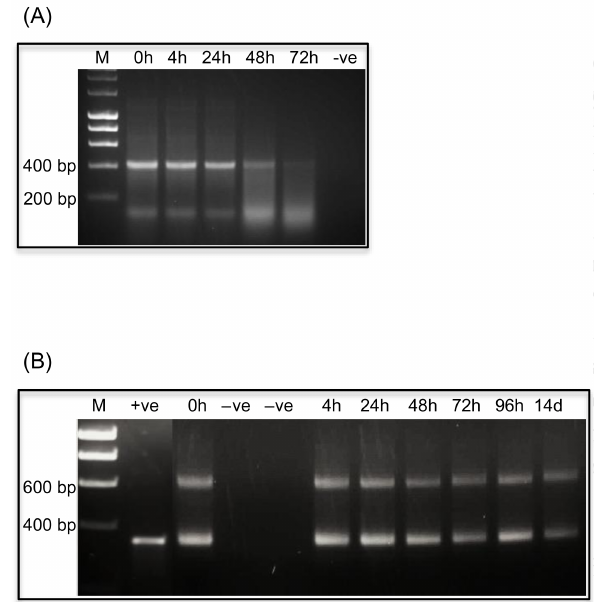
Figure 4. dsRNA stability over time in ( A ) aphid diet and ( B ) in wheat flour discs in the presence of feeding insects. For Ap , − ve control denotes diet only. Fot Tc +ve control denotes dsRNA alone; − ve controls are flour disc alone and flour disc with